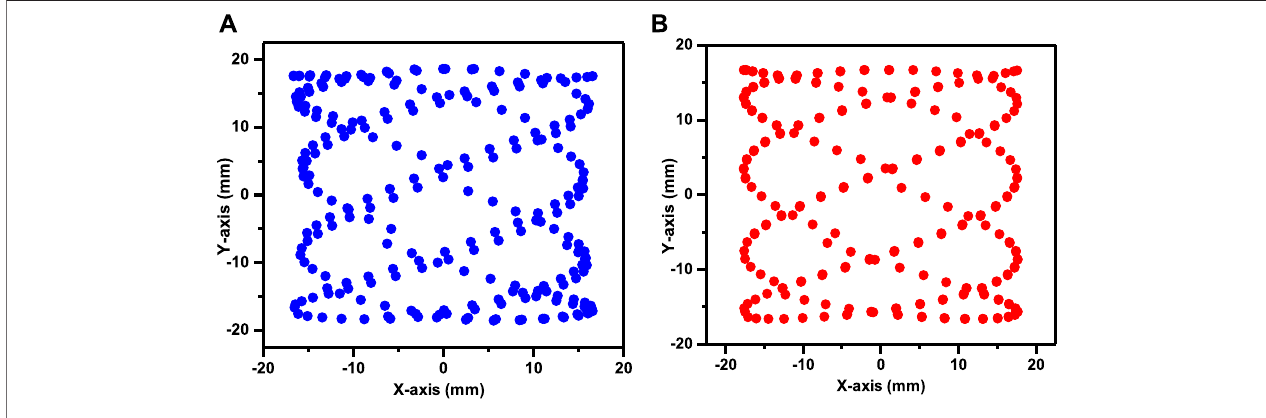
FIGURE9|(A,B) ThespotpatternsofthreedifferentMPCs( C bluedot, C reddot)onsphericalmirrorM 1 stimulatedbyopticalsoftwareandmodi fi edABCDmatrix model, respectively. The optical parameters of spot patterns are identical to that in Figure 6 .